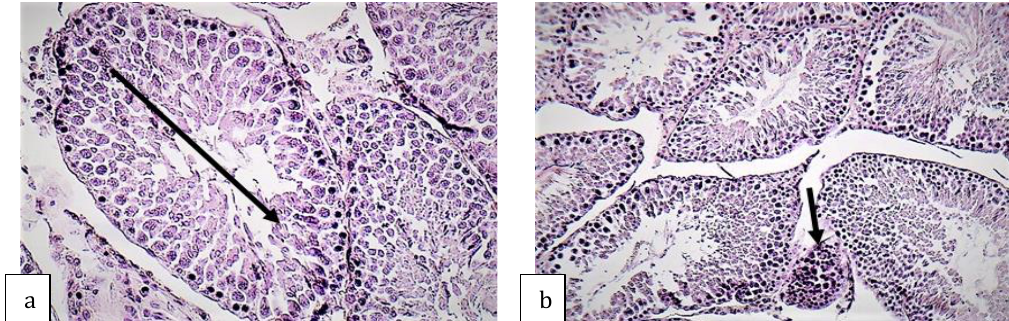
Figure 4. A photomicrograph of the right testis of an adult male Wistar rat received H 2 O 2 (G1): showing a) necrosis of spermatogonial (arrow) spermatids and loss of sperms (H&E, 400×), b) severe necrosis of tubules and marked focal pyknotic necrotic spermatogonial cells (arrow) (H&E, 100×)